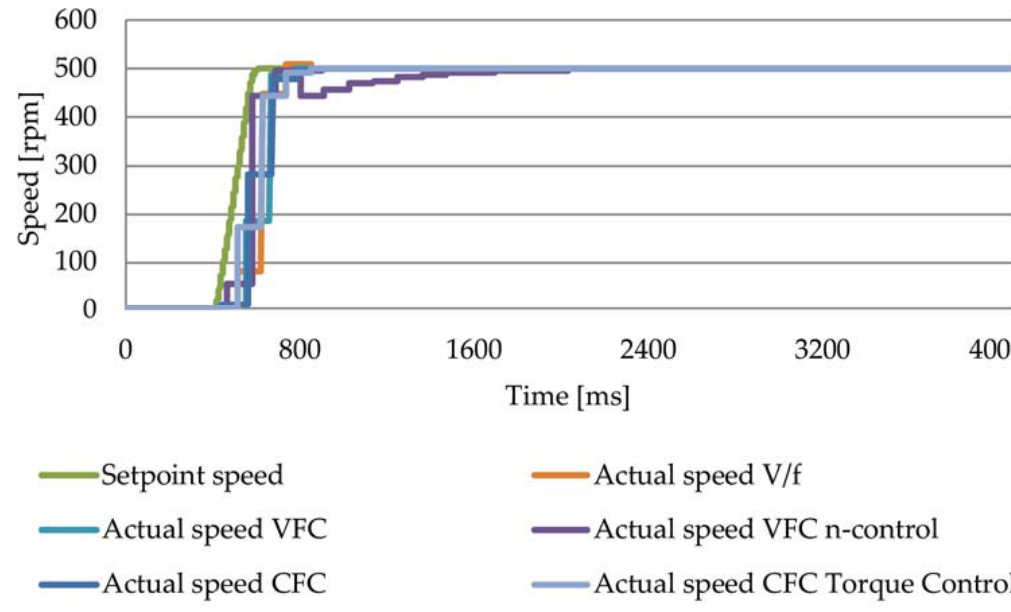
Figure 4. Comparison of the rotational speed (n A ) for various control modes, where VFC is VFC without an encoder. Table 7 shows the values of the overshoot of the rotational speed in the transient state in the unloaded condition. Table 7. Value of the overshoot of the rotational speed in the transient state (without an external load).